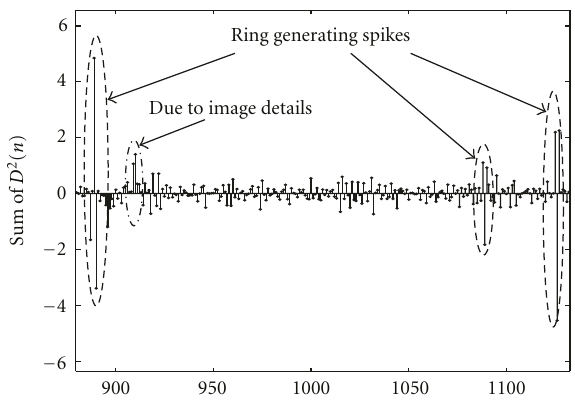
Figure 1: A cropped view of the sum of the second derivative of the whole sinogram ( (cid:2) P ( θ , n )) versus detector position—explaining the necessity of a local threshold instead of a global